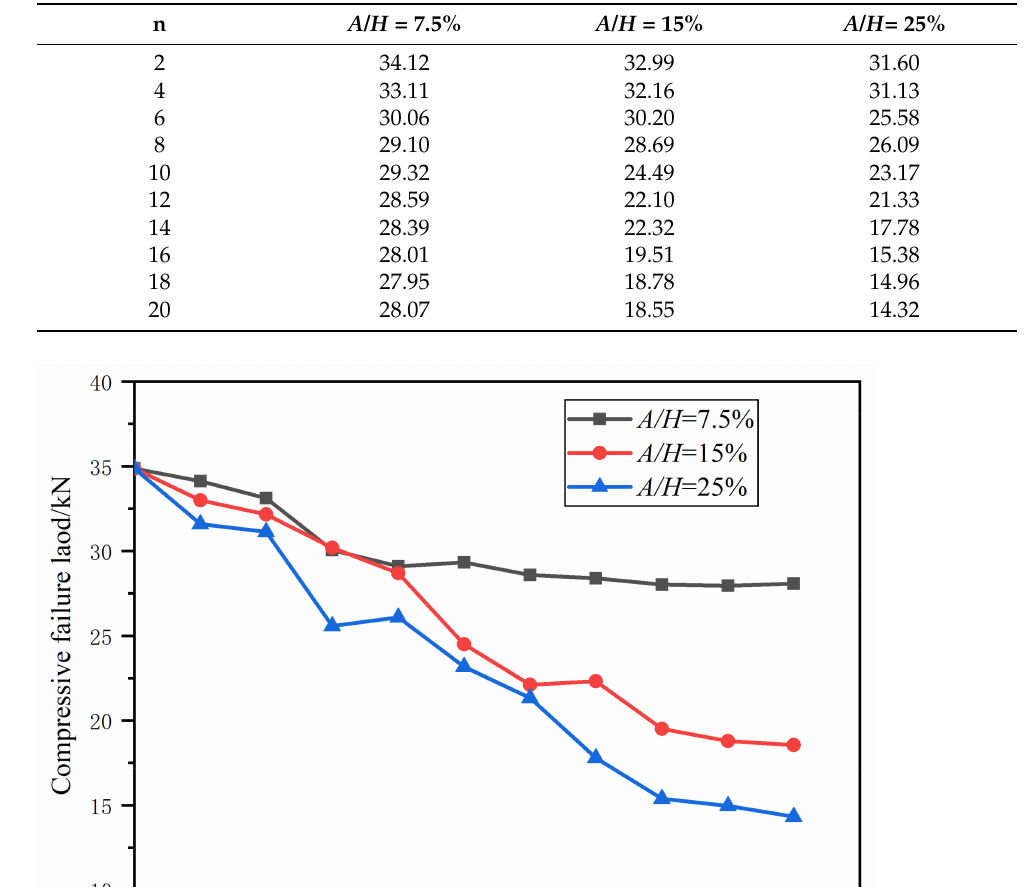
Table 6. Compressive failure load (kN) with different n for positive aspect ratios.